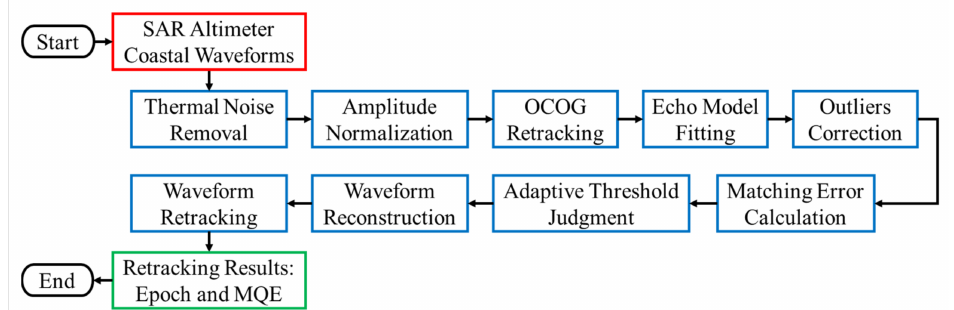
Figure 9. Processing flow of the SAR altimeter coastal waveforms.